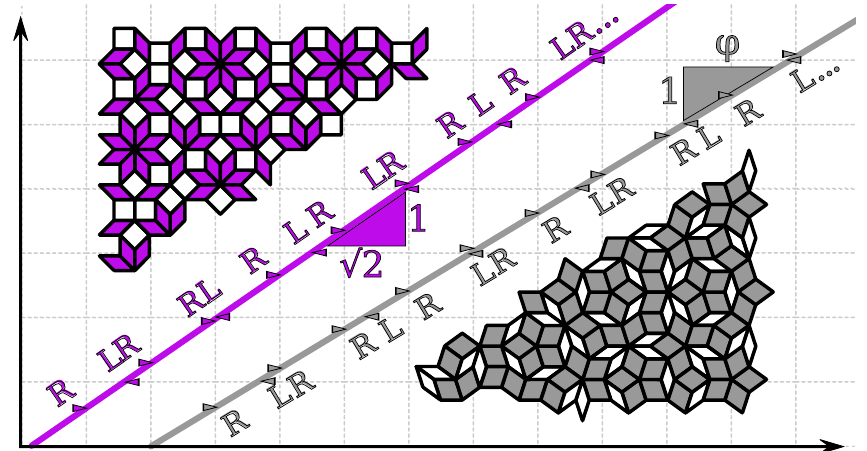
Figure 2: The two cells of a quasilattice can be generated by drawing an irrationally- sloped line through a two-dimensional regular lattice; when the line cuts a vertical line, write R , and when it cuts a horizontal line, write L . The grey line shows the (cid:112) (cid:0) (cid:1) / Fibonacci quasilattice being generated by a line with inverse slope ϕ = 1 + 2 5 the golden ratio; the purple line shows the Pell quasilattice being generated by a line (cid:112) with inverse slope related to 1 + 2 the silver ratio. Physically-relevant quasilattices have higher-dimensional counterparts in Penrose-like tilings with symmetries which can be realised by physical quasicrystals. The counterparts of the Fibonacci and Pell quasilattices are the Penrose tiling (grey and white, lower) and Ammann-Beenker tiling (purple and white, upper), respectively [ 2 ]